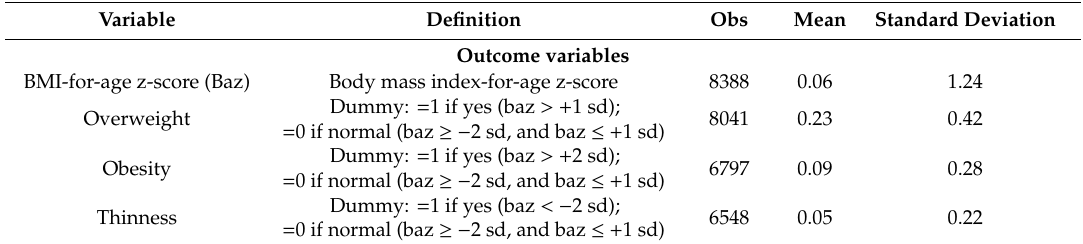
Table 1. Summary statistics of outcome variables.